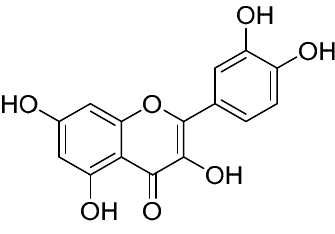
Figure 19. Structure of Quercetin.